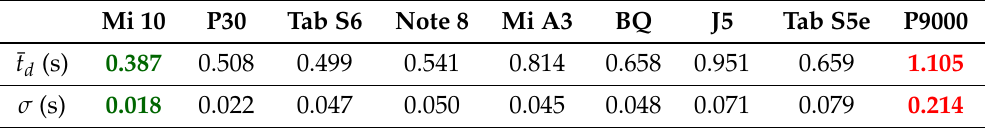
Table 2. Beacon decoding time t d (s) and its standard deviation σ (s) for each device.Each parameter’s best values are in bold green, and the worst values are in bold